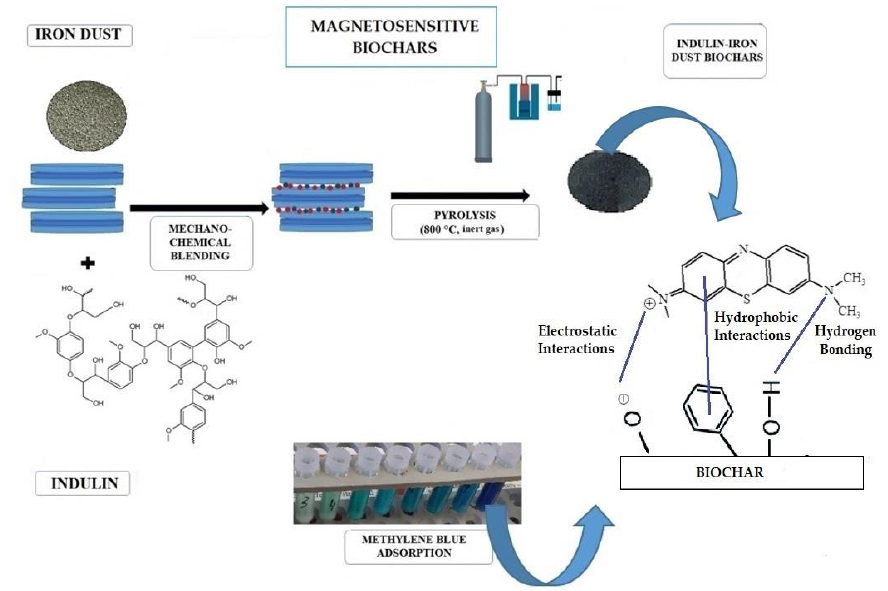
Figure 6. The scheme of biochars synthesis with the possible mechanism of methylene blue adsorp-